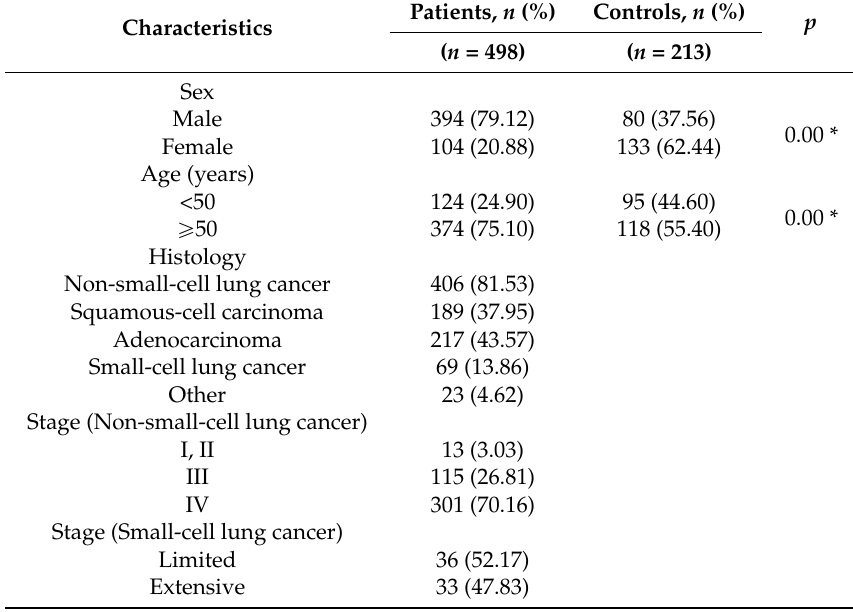
Table 1. Subjects characteristics.